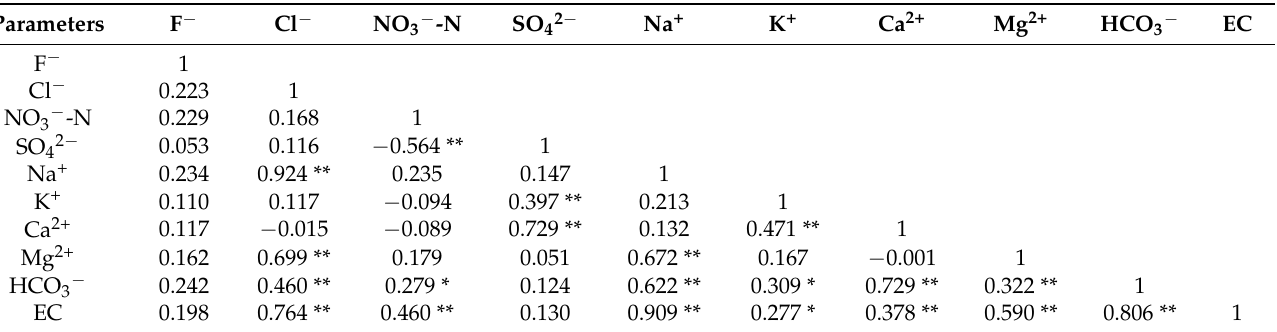
Table 3. Pearson’s correlation coefficients between major